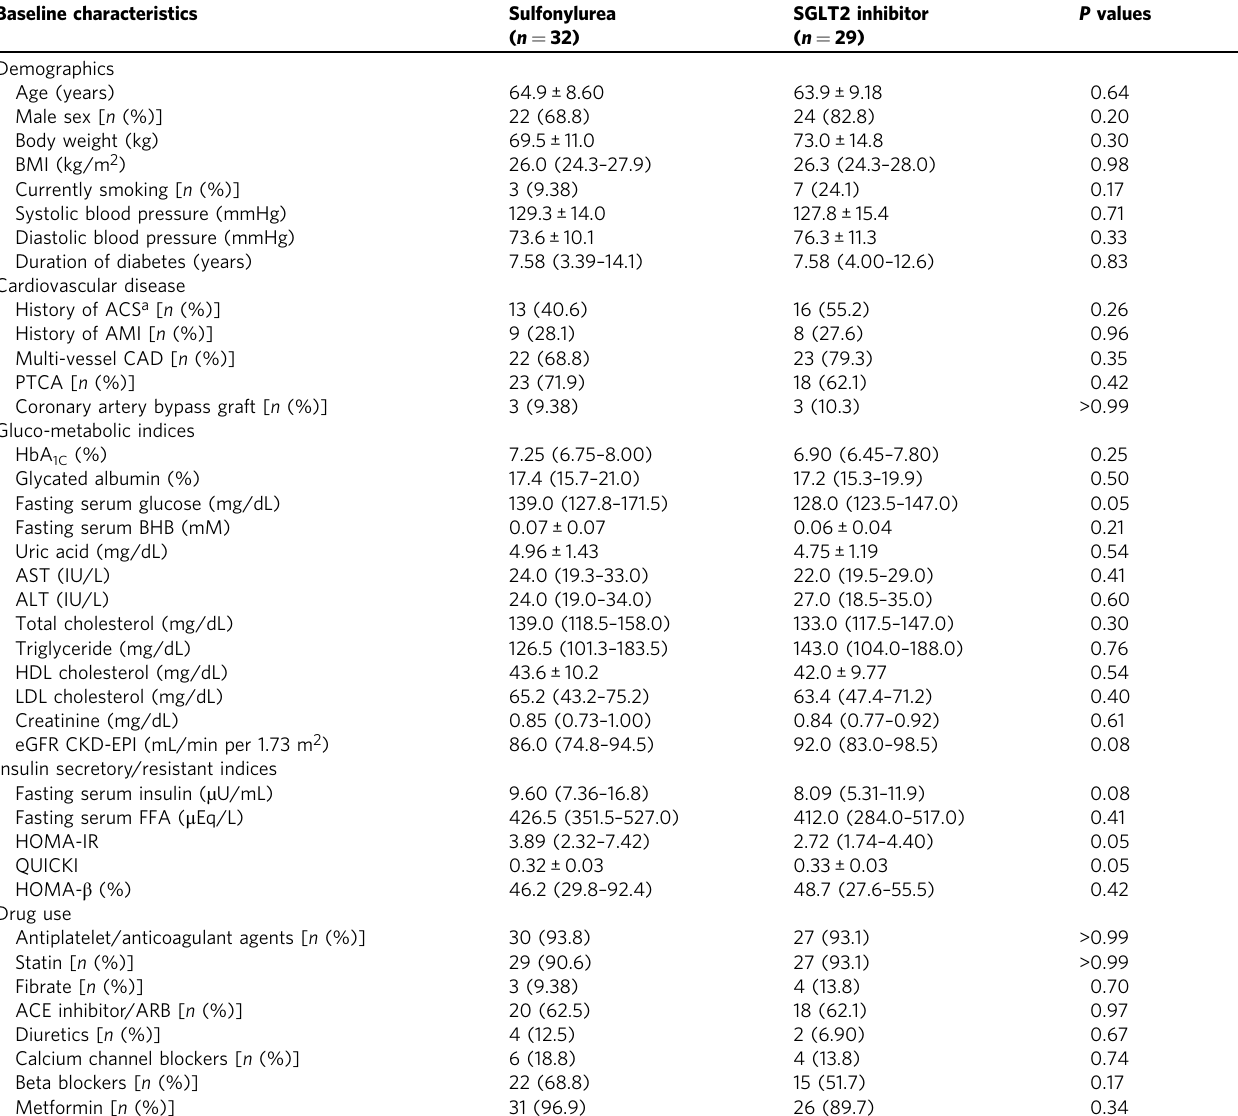
Table 1 Baseline characteristics of study